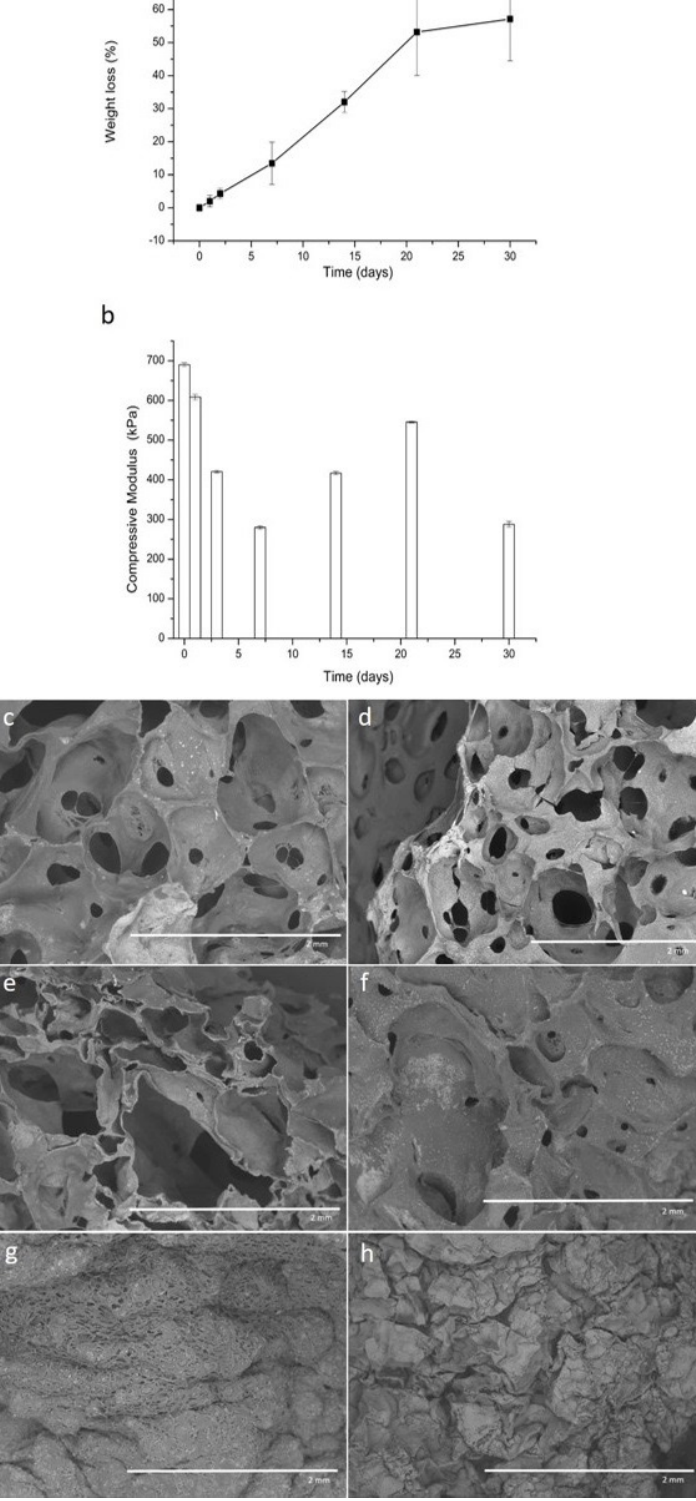
Figure 4. a. Degradation test of G-PVAFL; b. G-PVAFL compressive modulus as a function of the degradation time; c-h. SEM micrographs of polymers at various time points of degradation (c) 1 day; (d) 3 days; (e) 7 days; (f) 14 days; (g) 21 days and (h) 30